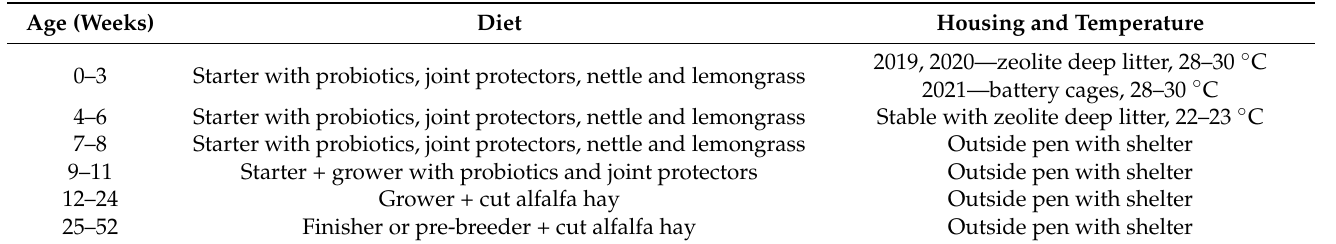
Table 3. Feeding and husbandry system of